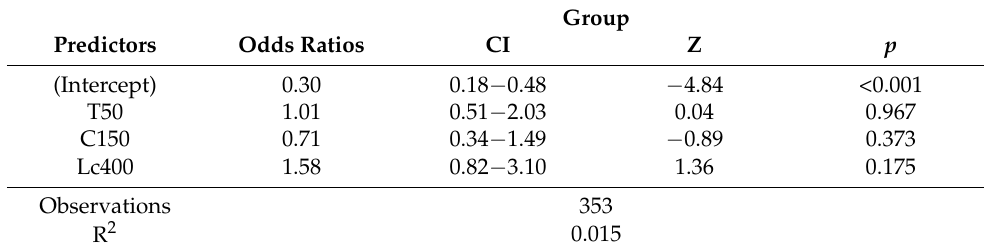
Table A3. Relation between the place of residence and Group classification after matching